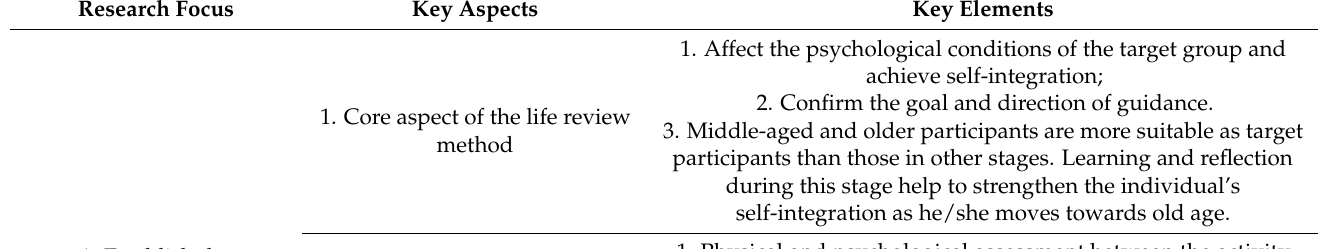
Table 1. Research focus and key elements for the implementation of life review activities. Research